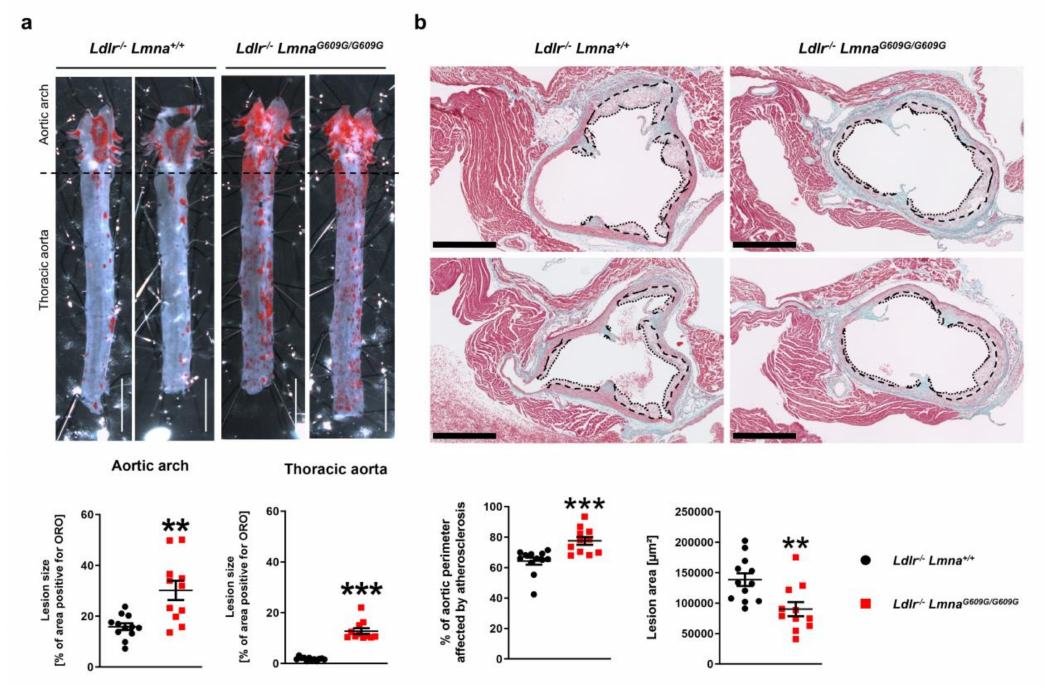
Figure 2. Male fat-fed Ldlr − / − Lmna G609G / G609G mice have an elevated atherosclerosis burden in the aortic arch and thoracic aorta and a higher percentage of the aortic perimeter a ff ected by atherosclerosis in the aortic root. Male mice were fed a high-fat diet from eight weeks of age and were sacrificed at 16 weeks of age. ( a ) Representative images of aortas stained with Oil Red O (ORO) and quantification of atherosclerosis burden (the percentage of the aortic surface positive for ORO) in the aortic arch and thoracic aorta of Ldlr − / − Lmna +/+ mice ( n = 12) and Ldlr − / − Lmna G609G / G609G mice ( n = 11). Scale bar, 5 mm. ( b ) Representative images of aortic root sections stained with Masson trichrome and quantification